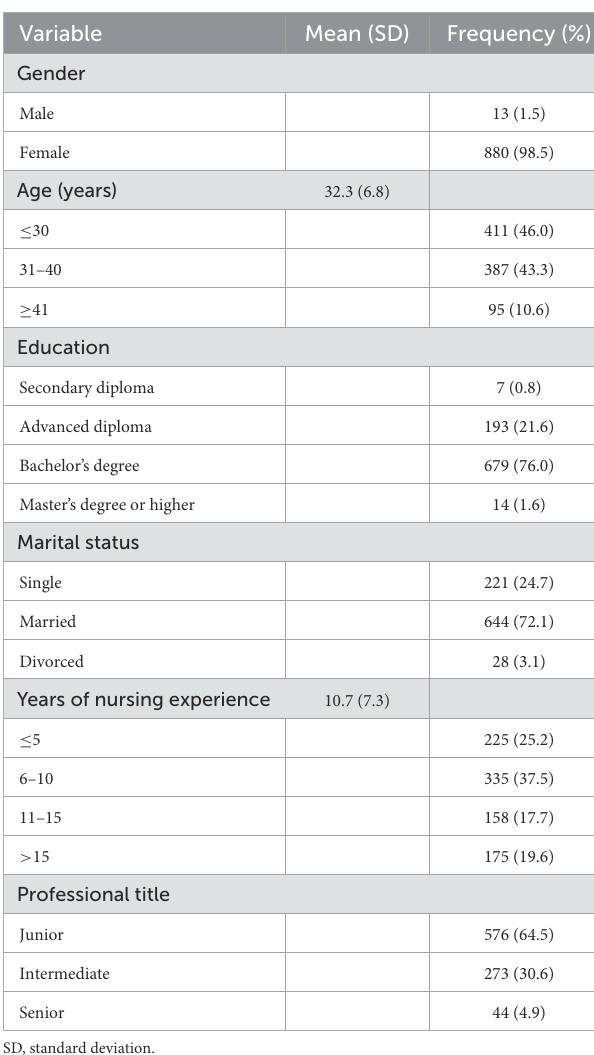
TABLE 1 Demographics of the participants ( N =